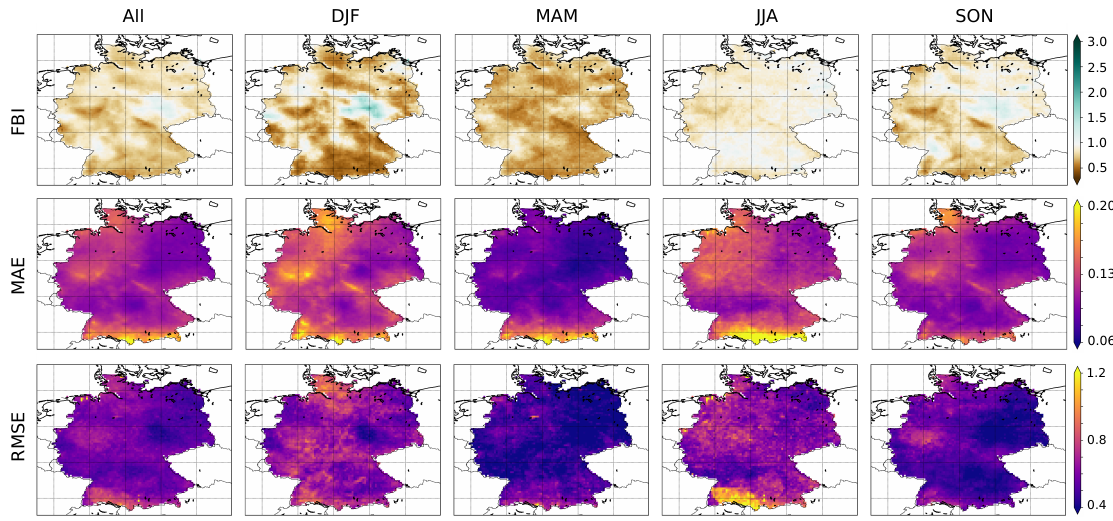
Figure 8. FBI, MAE, and RMSE for for total review period, DJF, MAM, JJA, and SON